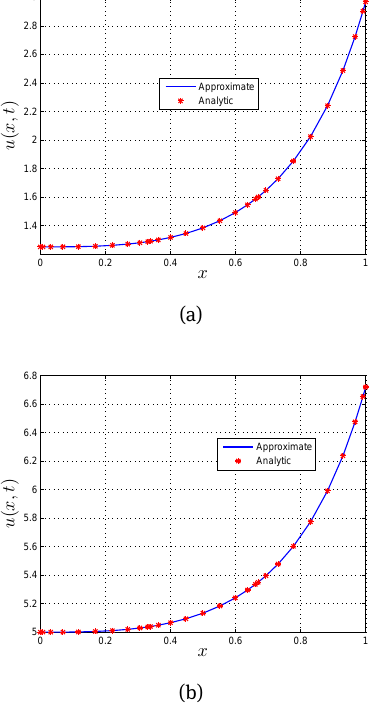
Figure 5: Analytical and approximate solution for example 4 when k = 1, p = 2 at (a) t = 0.5 and (b) t = 2